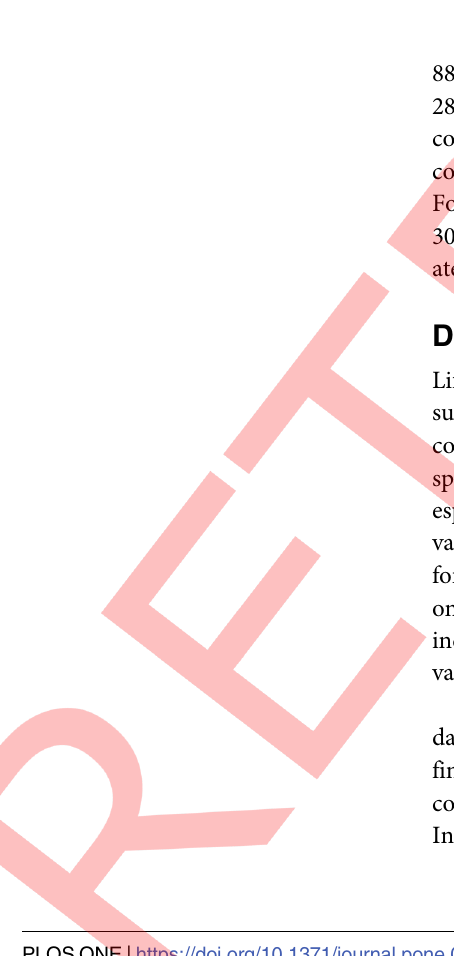
Fig 4. Effect of HaNPV, insecticides and their combinations on age-stage specific survival ( l benzoate selected population of Helicoverpa armigera .